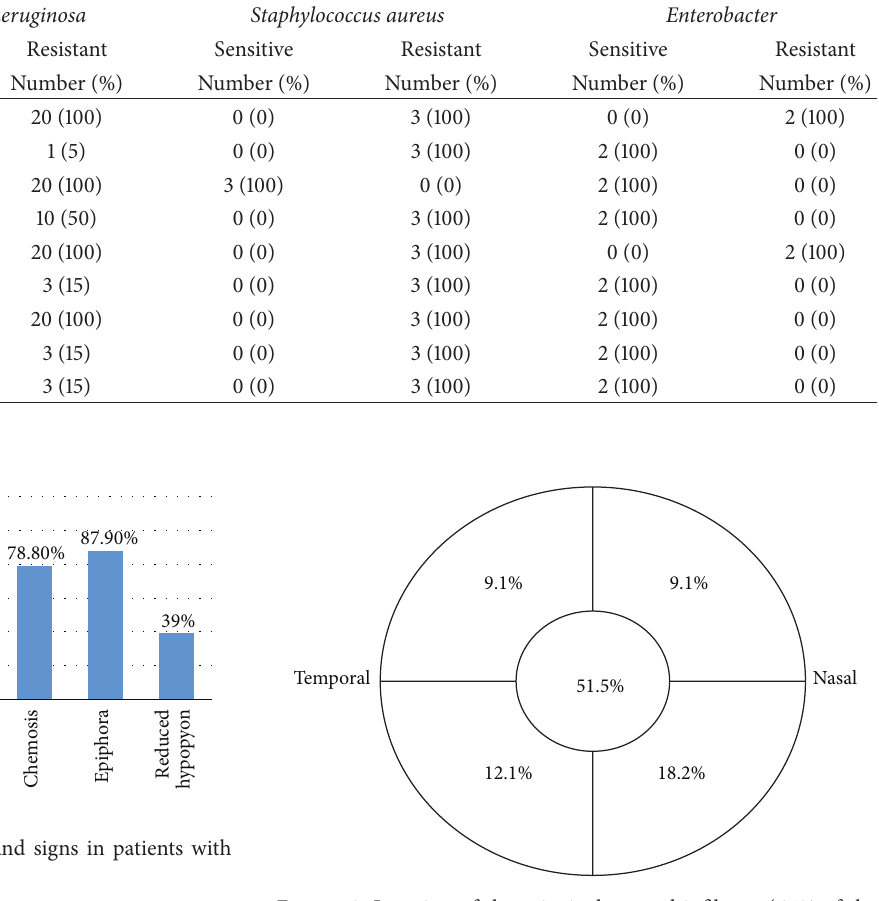
Figure 2: Location of the principal corneal infiltrate (6.1% of the infiltrates were